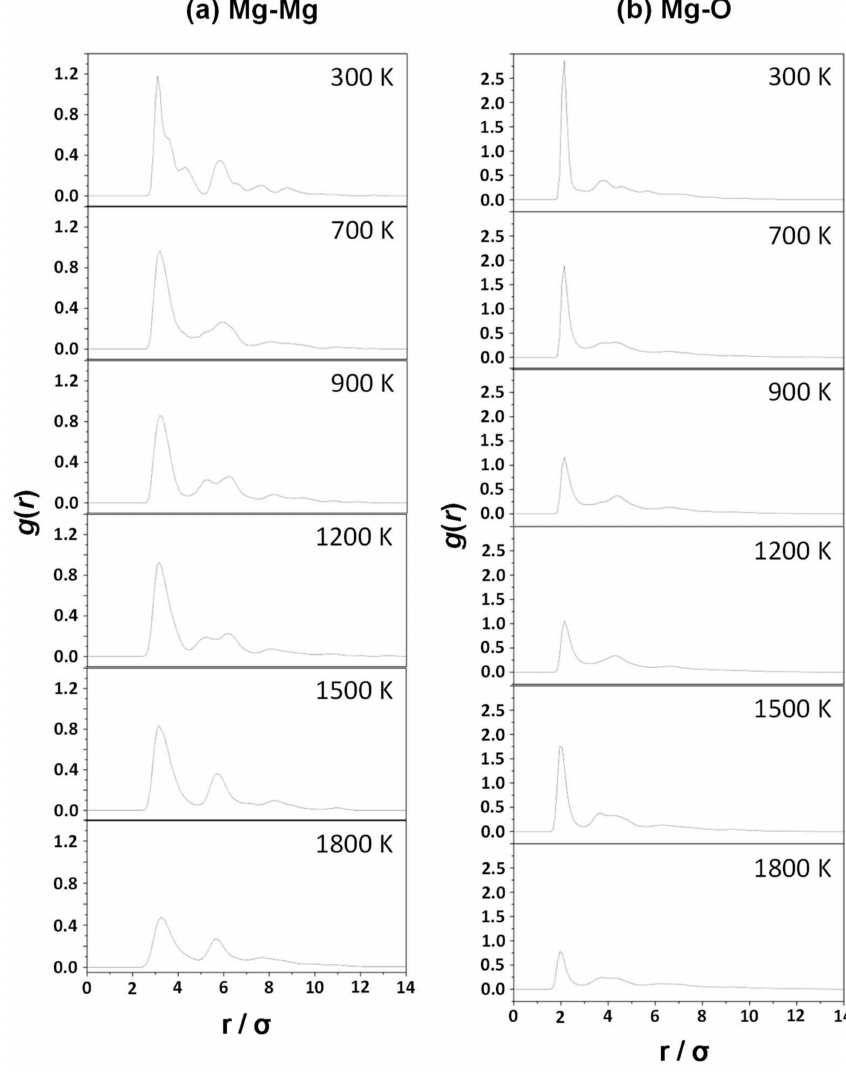
Figure 3. Mg–Mg ( a ) and Mg–O ( b ) pair correlation functions, g(r), derived from the MD simulations at the different